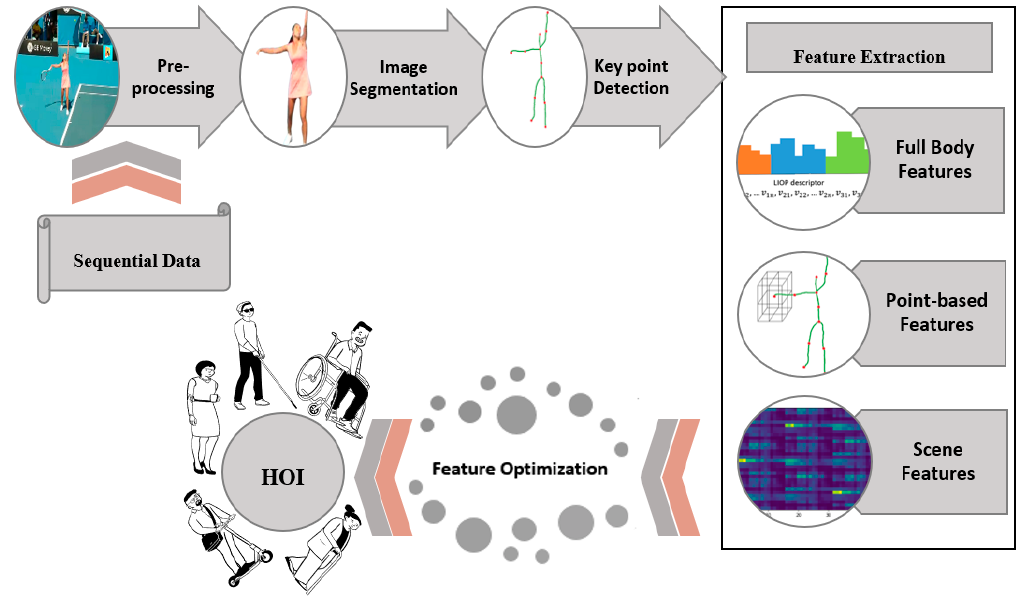
Figure 1. The architecture of the proposed HOI recognition